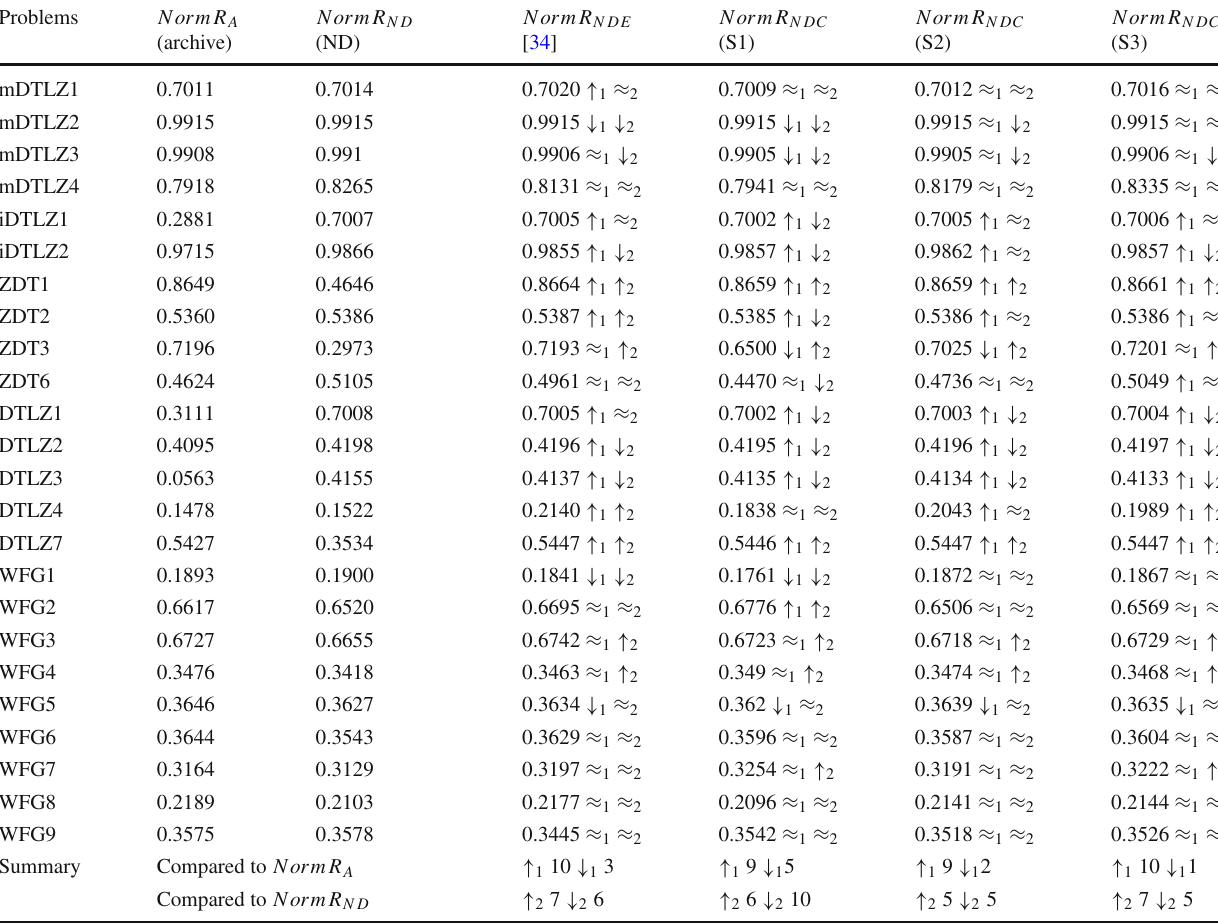
Table 2 Median HV performance in test problems with 2 objectives across 29 independent runs